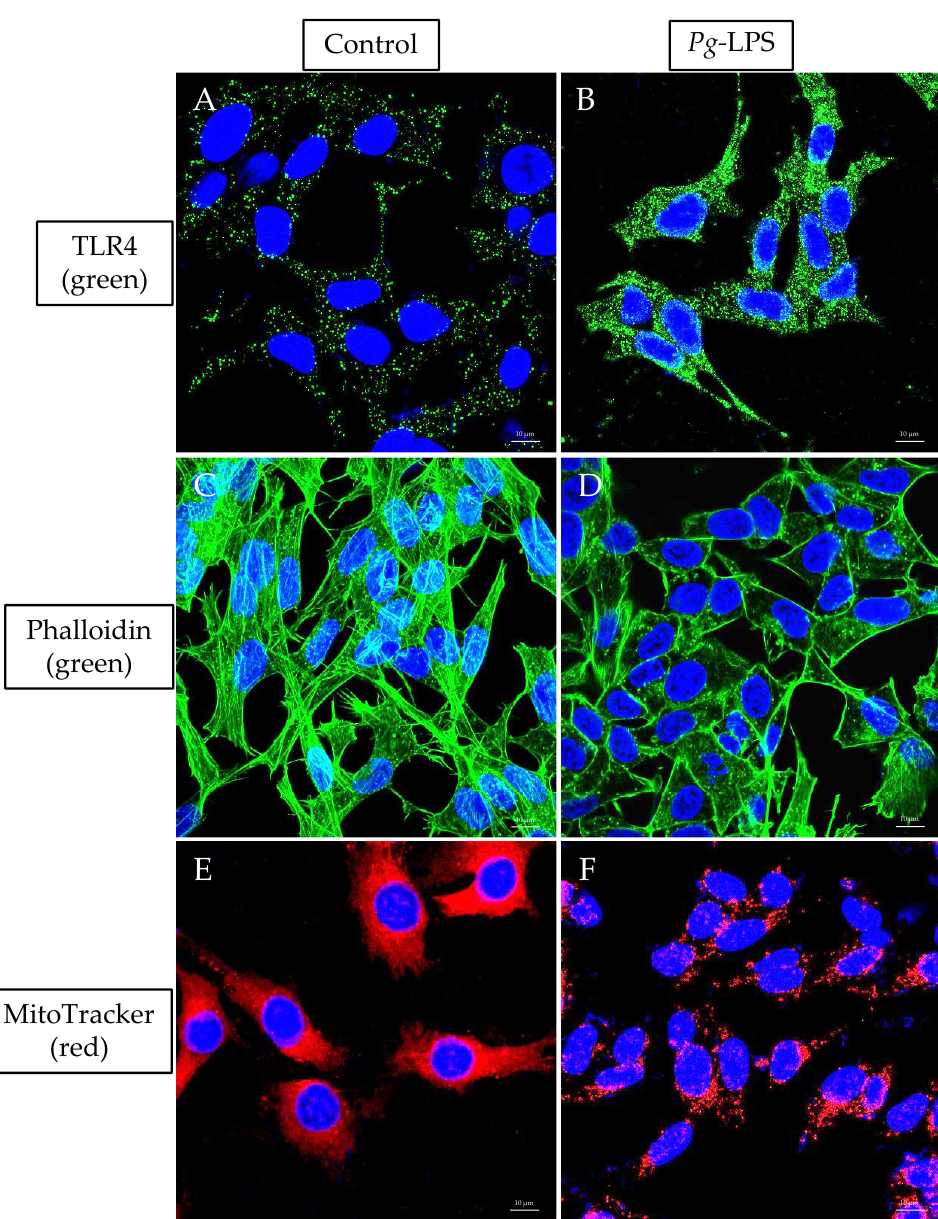
Figure 7. Immunolabeling of TLR4, Actin and MitoTracker. The cells were incubated with Anti-TLR4 Antibody (green), phalloidin (green) and MitoTracker (red) conjugated dyes. DAPI (blue) was used for nuclear counterstaining. Untreated ( A , C , E ) and LPS-treated ( B , D , F ). A 63× oil objective was used; scale bars indicate 10 μm.